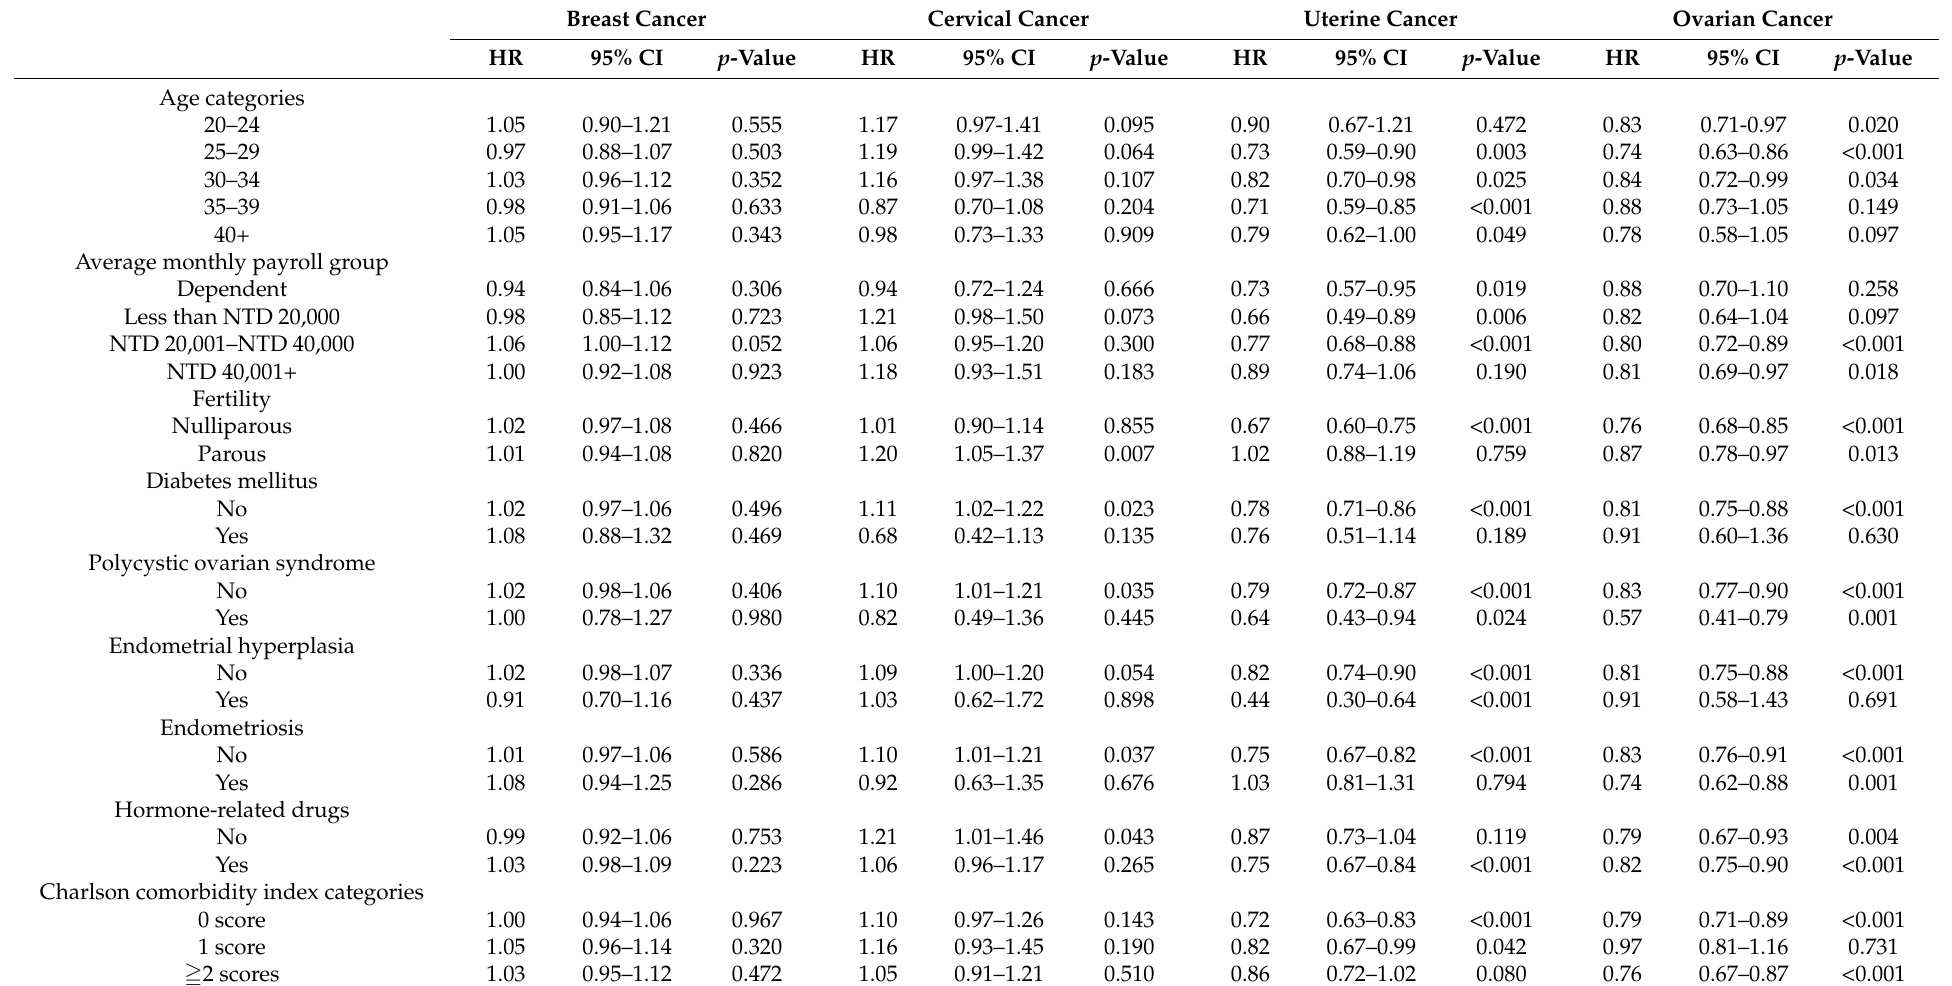
Table 4. Stratification analysis of the risks of abortion for incident female cancers from Cox proportional hazard models. Breast